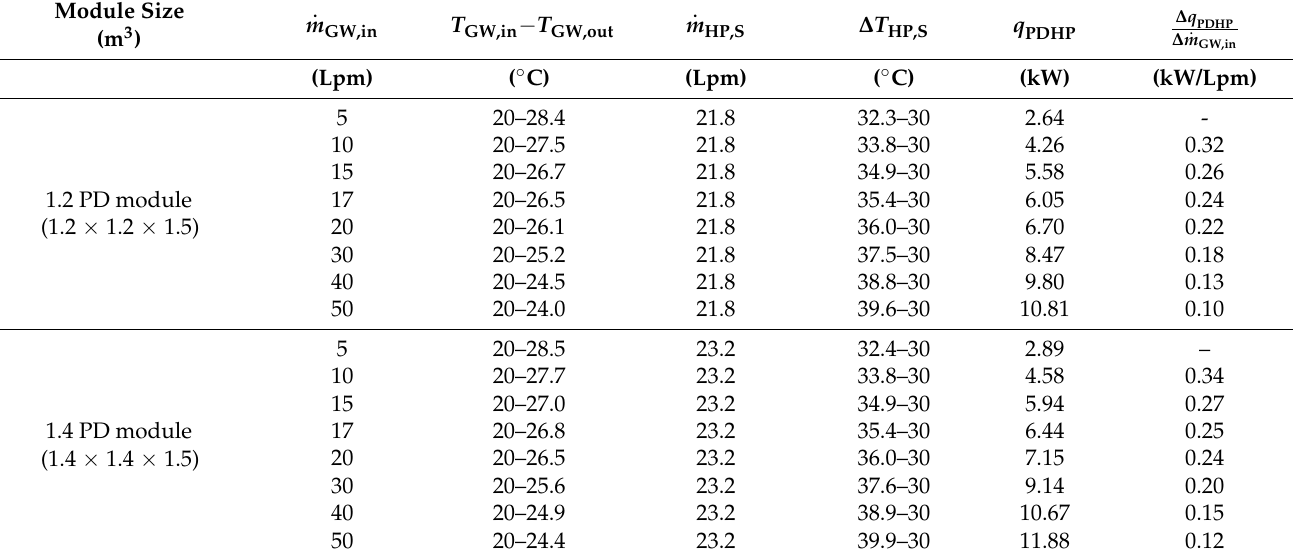
Table 7. PD module sizing results for constant (marked by a circle in Figure